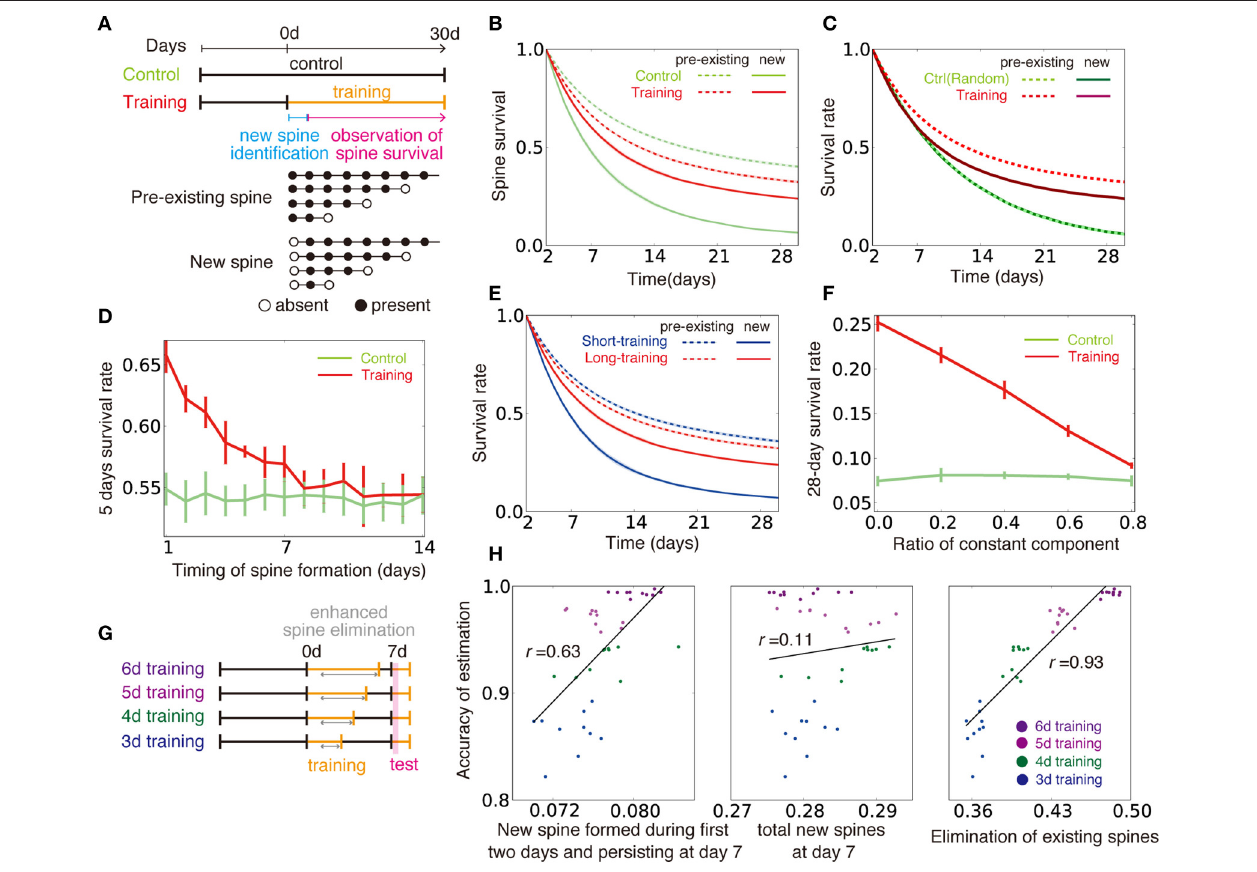
FIGURE 8 | Influence of training on spine dynamics. (A) Schematic diagrams of the simulation protocols for (B–F) , and examples of spine dynamics for pre-existing spines and new spines. (B) Spine survival rates for control and training simulations. Dotted lines represent survival rates of pre-existing spines (spines created before day 0 and existing on day 2), and solid lines are new spines created between day 0 and day 2. (C) Spine survival rates when control was modeled with random Gaussian inputs r t X , j σ 2 M ζ t j , instead of a pattern { θ ctrl }. Note that light-green line is hidden under dotted green line, because two lines σ 2 x 0.75 µ M + = + show nearly identical dynamics. (D) The 5-day survival rate of spines created at different stages of learning. (E) Spine survival rates for short-training (2 d) q